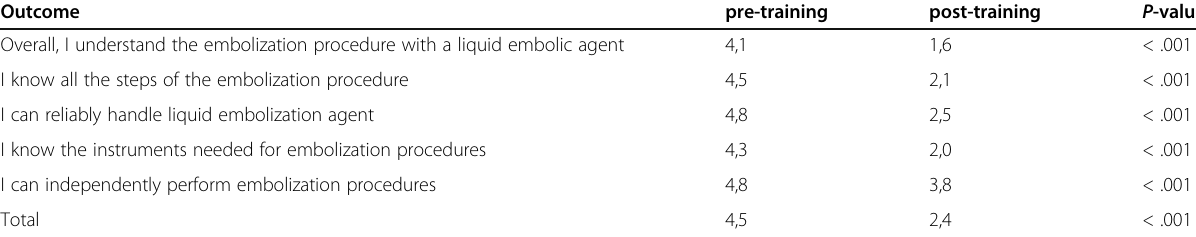
Table 4 Differences in self-reported assessment of the novices before and after the training ( n = 12) Outcome